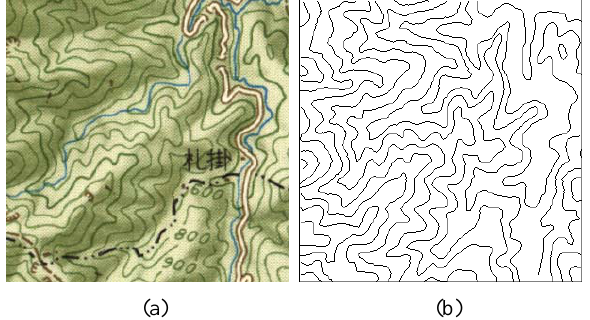
Figure 11. A part of a scanned colour topographic map with relief shadings. a Original image. b Vectorization result of contour lines